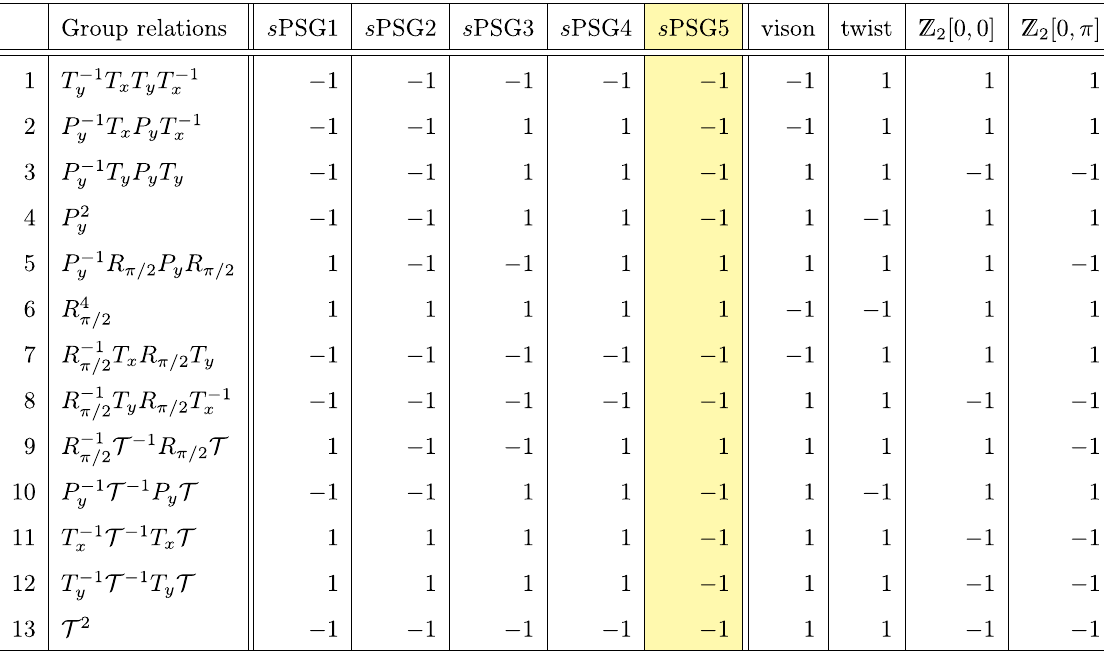
FIG. 9. The columns labeled “ s PSG 1 - 5 ” list the symmetry fractionalizations of the gapped, symmetric Z 2 spin liquids given in Fig. 7. The corresponding bosonic symmetry fractionalization numbers are obtained by multiplying the s PSG numbers with the those given in the Vison and Twist columns. We see that s PSG5 corresponds to the Z 2 ½ 0 ; 0 (cid:4) state of Ref. [23]. No bosonic counterparts to s PSG1 – 4 are present in Ref.